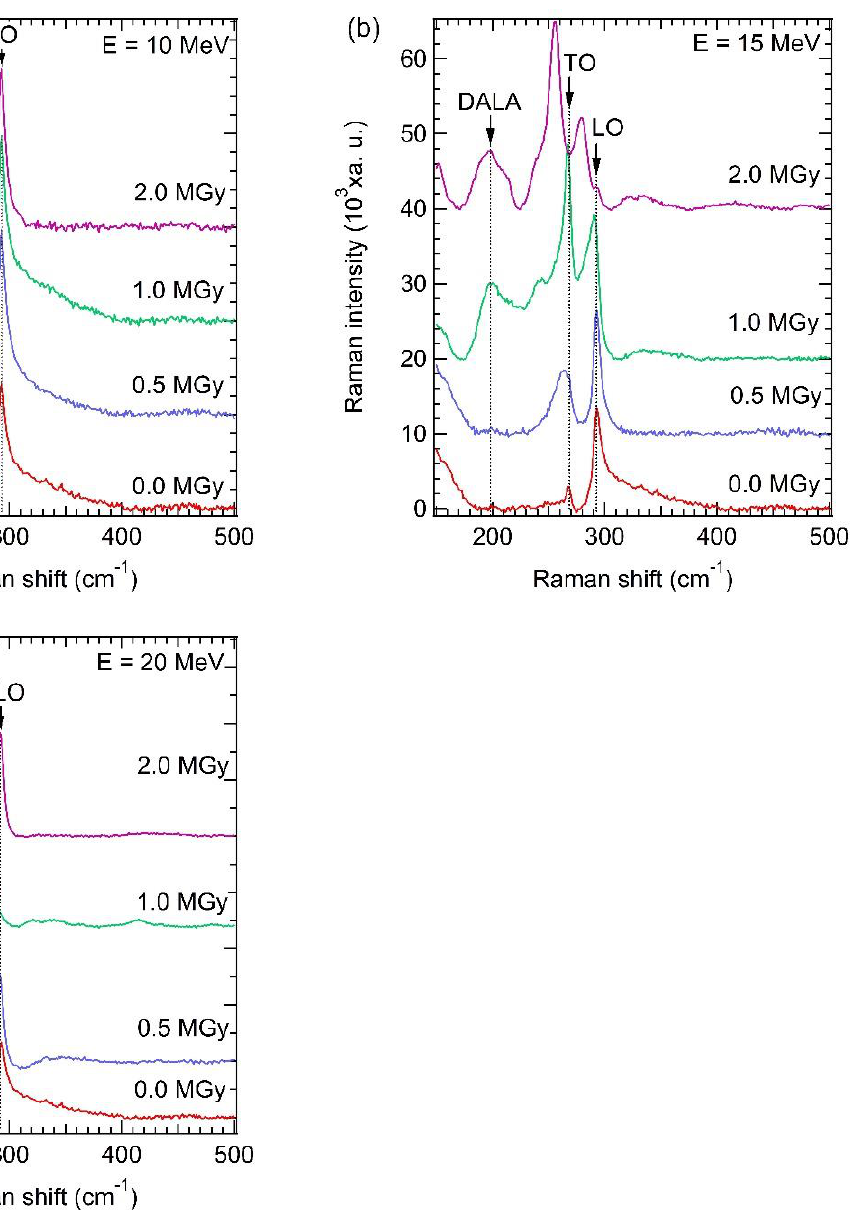
Figure 8. Raman spectra of GaAs samples irradiated with electron beam at ( a ) 10; ( b ) 15; and ( c ) 20 MeV.